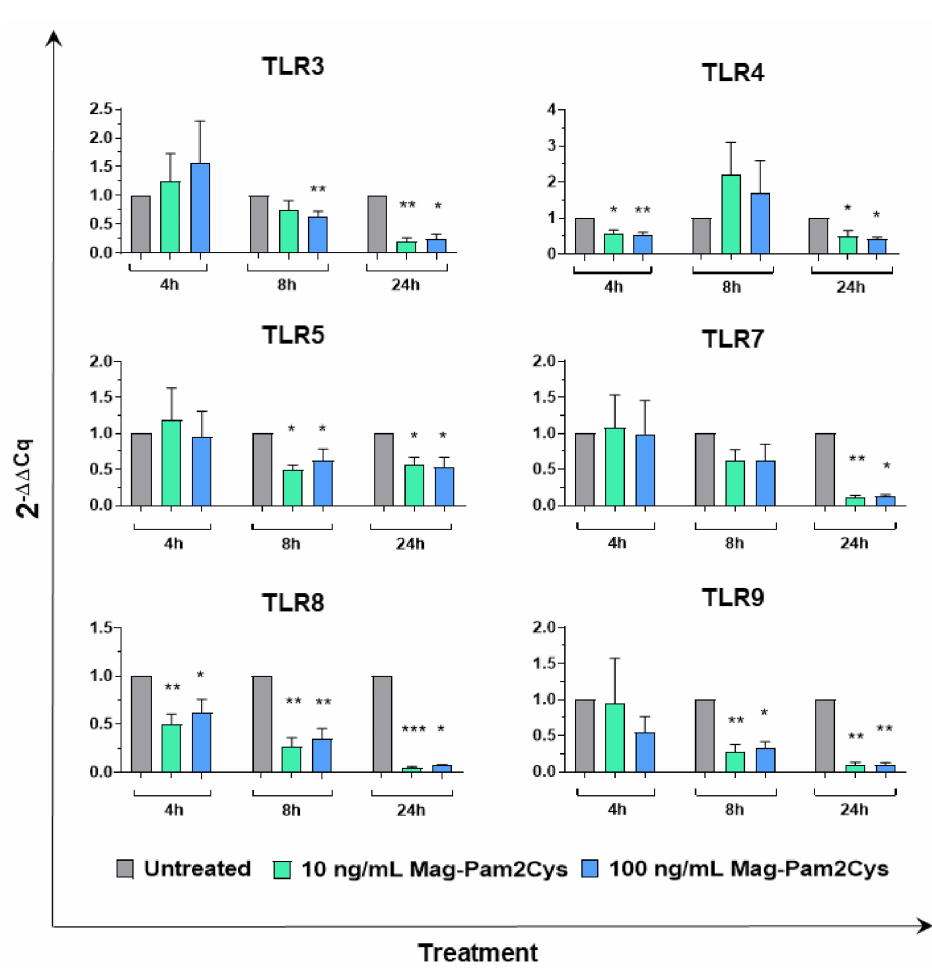
Figure 8. Toll-like receptors’ (TLRs) gene expression in moM Φ following stimulation with Mag- Pam2Cys. MoM Φ were left untreated or stimulated with scalar doses of Mag-Pam2Cys (10 or 100 ng/mL). At 4, 8, and 24 h post-stimulation, gene expression levels of six TLRs (TLR3, TLR4, TLR5, TLR7, TLR8, TLR9) were determined using qPCR. At each time point, data were normalized on the values of untreated control and expressed as 2 − ∆∆ Cq , with ∆ Cq = Cq (target gene)—Cq (reference gene), and ∆∆ Cq = ∆ Cq (Mag-Pam2Cys-stimulated samples)— ∆ Cq (untreated sample, moM Φ ). Mean data and SD from six independent experiments using different blood donor pigs are shown. For each time point, values of Mag-Pam2Cys stimulated samples were compared to the corresponding untreated control (moM Φ ) using a Kruskal–Wallis multiple comparison test. *** p < 0.001, ** p < 0.01, * p <